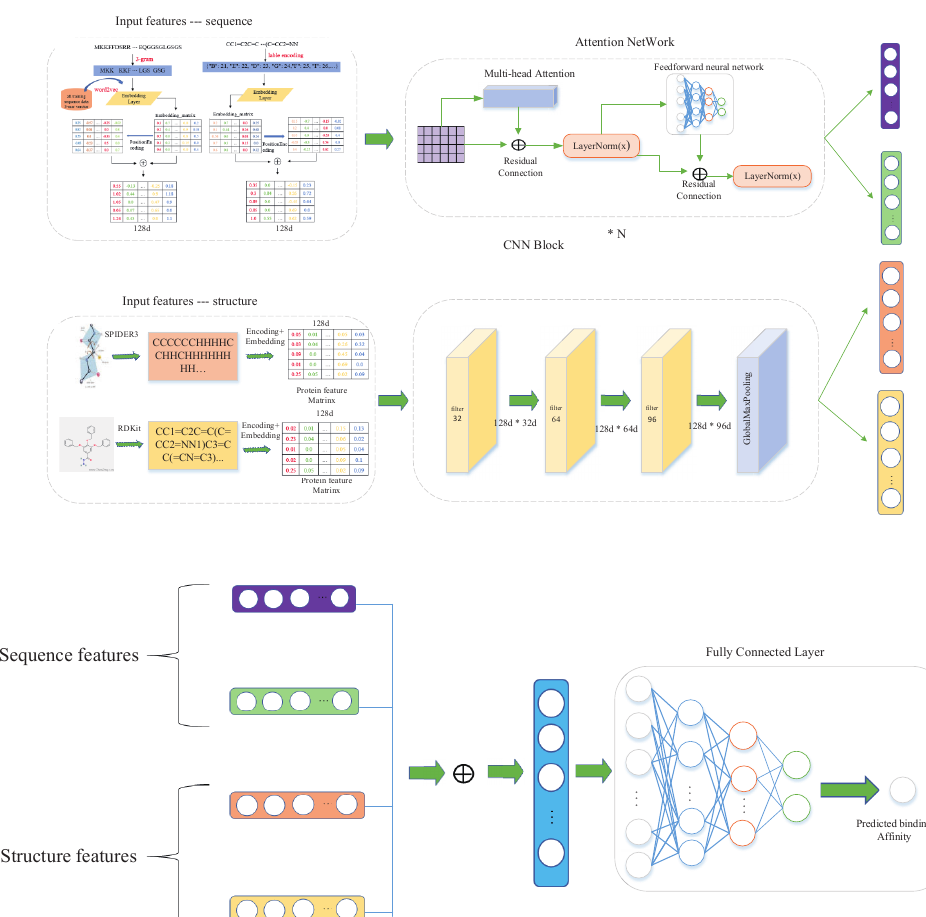
Figure 2. Architecture of our proposed model DeepMHADTA. The model combines sequence and structure information of protein and drug via CNN block for feature extraction, and the embeddings are concatenated as input to fully connected layer for quantitative binding affinity